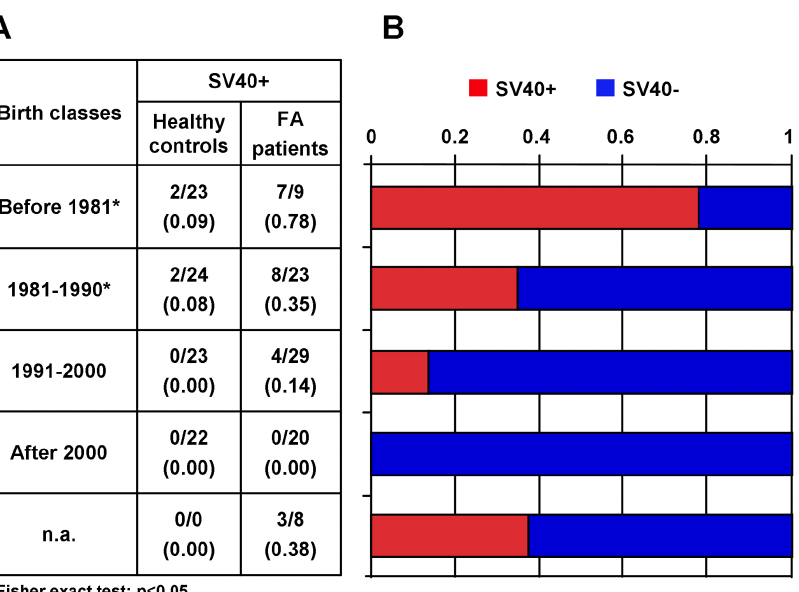
Figure 2. Birth class distribution of FA patients and healthy individuals. A) Table indicating the ratio of the SV40 positive individuals to the total of individuals tested. Healthy controls (No. 92) are matched with FA individuals (No. 84) by birth class. Years of birth for the class ‘‘before 1981’’ included 1 patient born in 1958 and 8 patients born between the years 1975 and 1980. n.a., year of birth not available. B) Histogram representing the relative frequency of the FA patients positive (red) and negative (blue) to SV40.